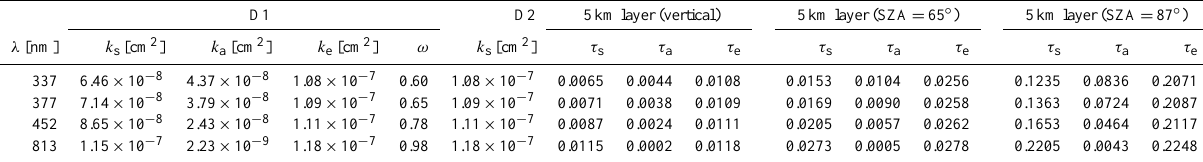
Table 3. Scattering, absorption and extinction cross-sections ( k s , k a , k e , respectively) of absorbing dust (D1) and the scattering cross-section of non-absorbing dust (D2) as a function of wavelength ( λ) . The single scatter albedo ( ω , unitless) of D1 is also shown. Note that the scattering optical thickness of D2 is equivalent to the extinction optical thickness of D1. The scattering, absorption and extinction optical thickness ( τ s , τ a , τ e , respectively, unitless) is shown for a 5km layer of D1, as described in Table 2, under three viewing conditions.